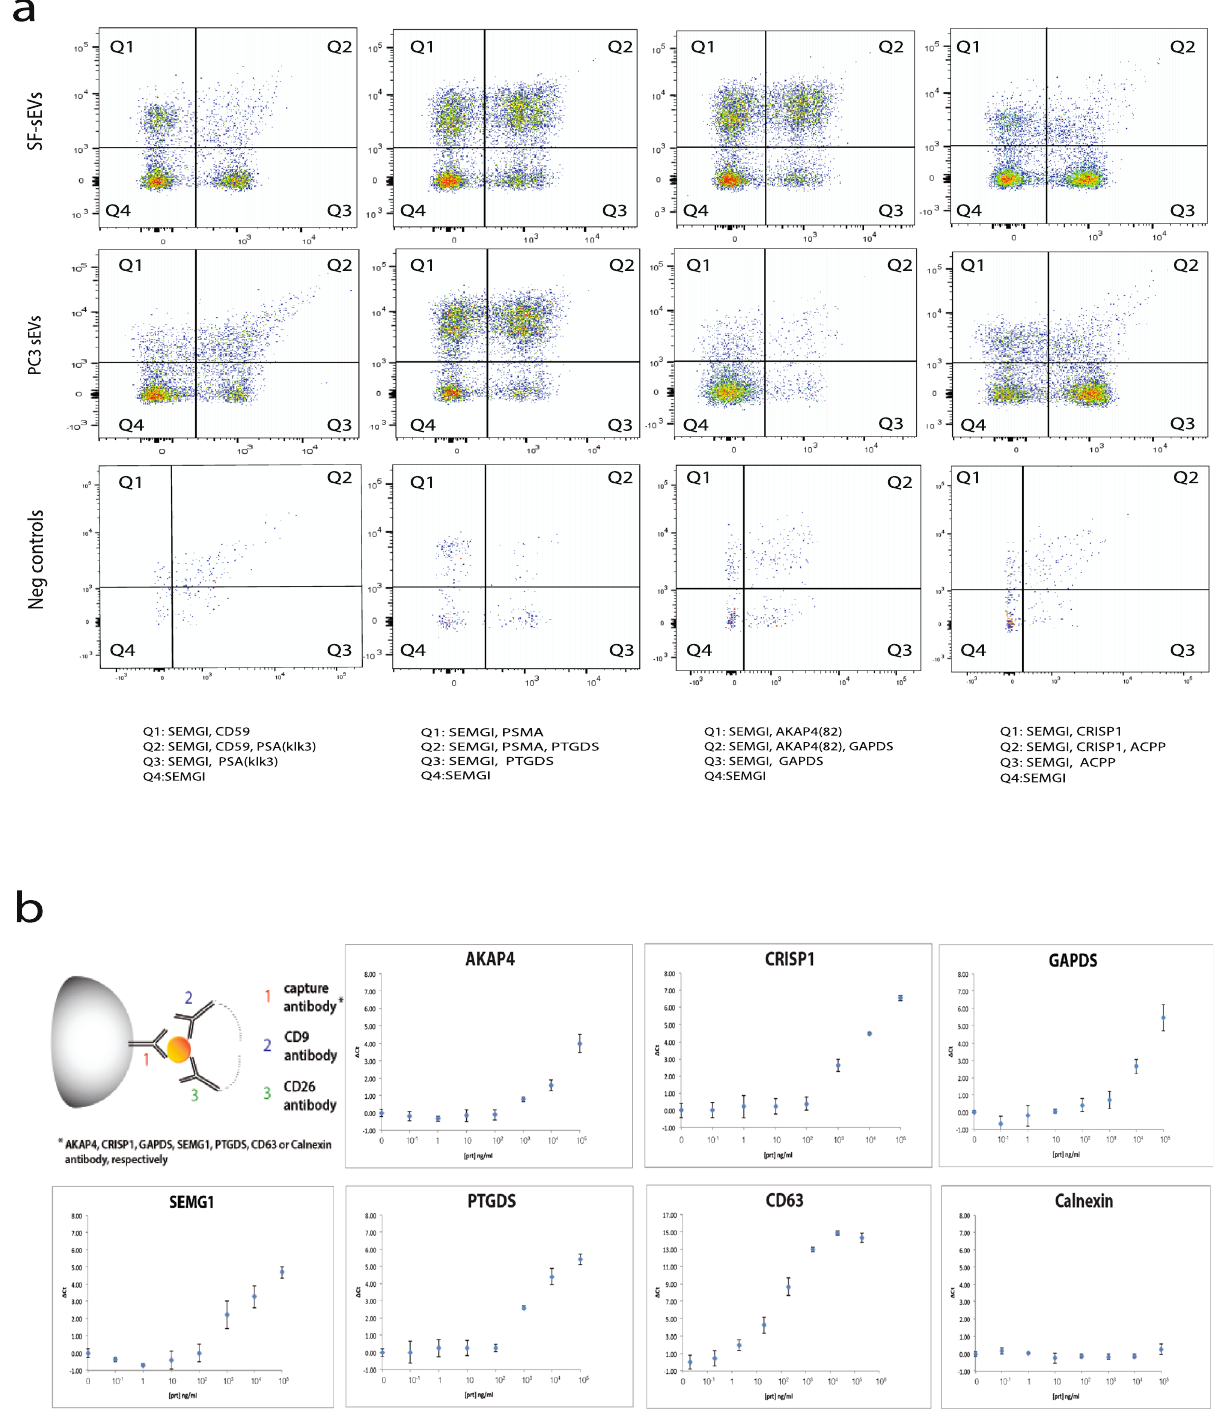
Fig. 5 Validation of surface protein markers on SF-sEVs and PC3 sEVs by Exo-PLA and SP-PLA. a Combination of different markers on the surface of sEVs detected by Exo-PLA. Gating of positive signals in fl ow cytometry and different populations are displayed. b SF-sEVs were captured by beads coated with antibodies for speci fi c targets identi fi ed by HRMS analyses (CRISP1, AKAP4, GAPDS, SMG1, and PTGDS), indicated for each panel, and detected with PLA probes against CD9 and CD26 markers. The abundant marker CD68 was used as capture for positive control of assay performances, the ER marker calnexin was used as negative control capture antibody. The x -axes display the concentration of samples in ng of total protein per ml. The y -axes display the differences between the threshold cycle for the real-time PCR readout of SP-PLA reactions for the samples and the threshold cycle of the negative control (assay buffer without samples). The error bars are representing standard deviation (SD), each sample was run in